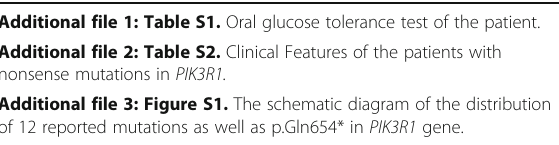
Additional file 1: Table S1. Oral glucose tolerance test of the